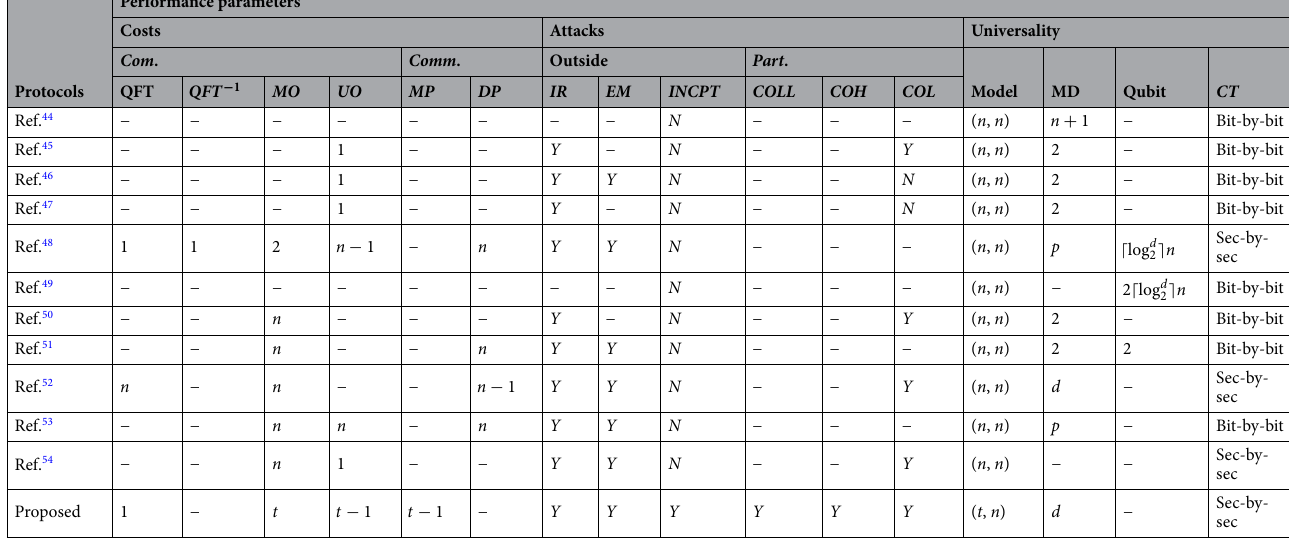
Table 2. Comparison with ten